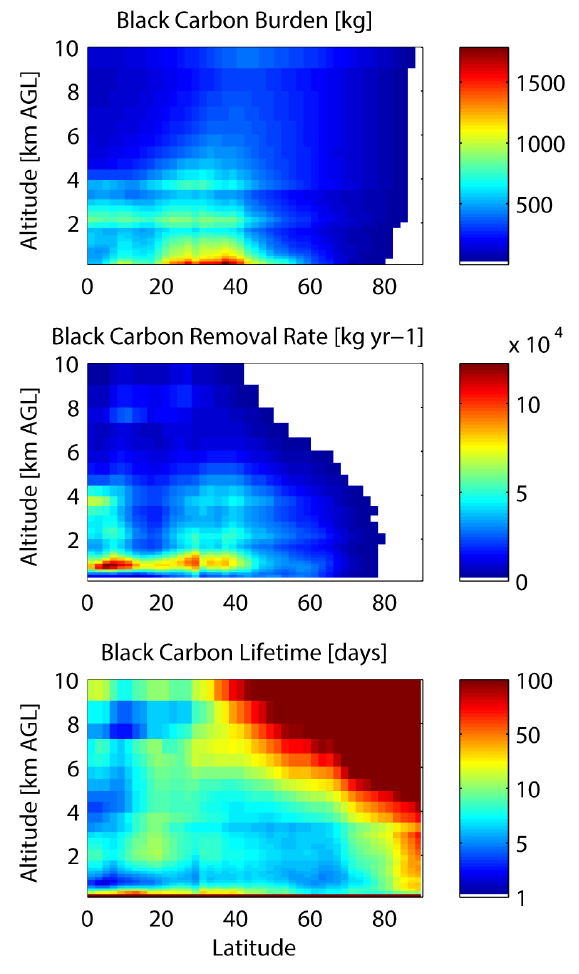
Fig. 6. Zonal, annual mean black carbon layer burdens (top panel), zonal, annual mean black carbon wet removal rates (middle panel), zonal, annual mean black carbon lifetimes with respect to wet de- position (bottom panel) for the standard GEOS-Chem aerosol sim-